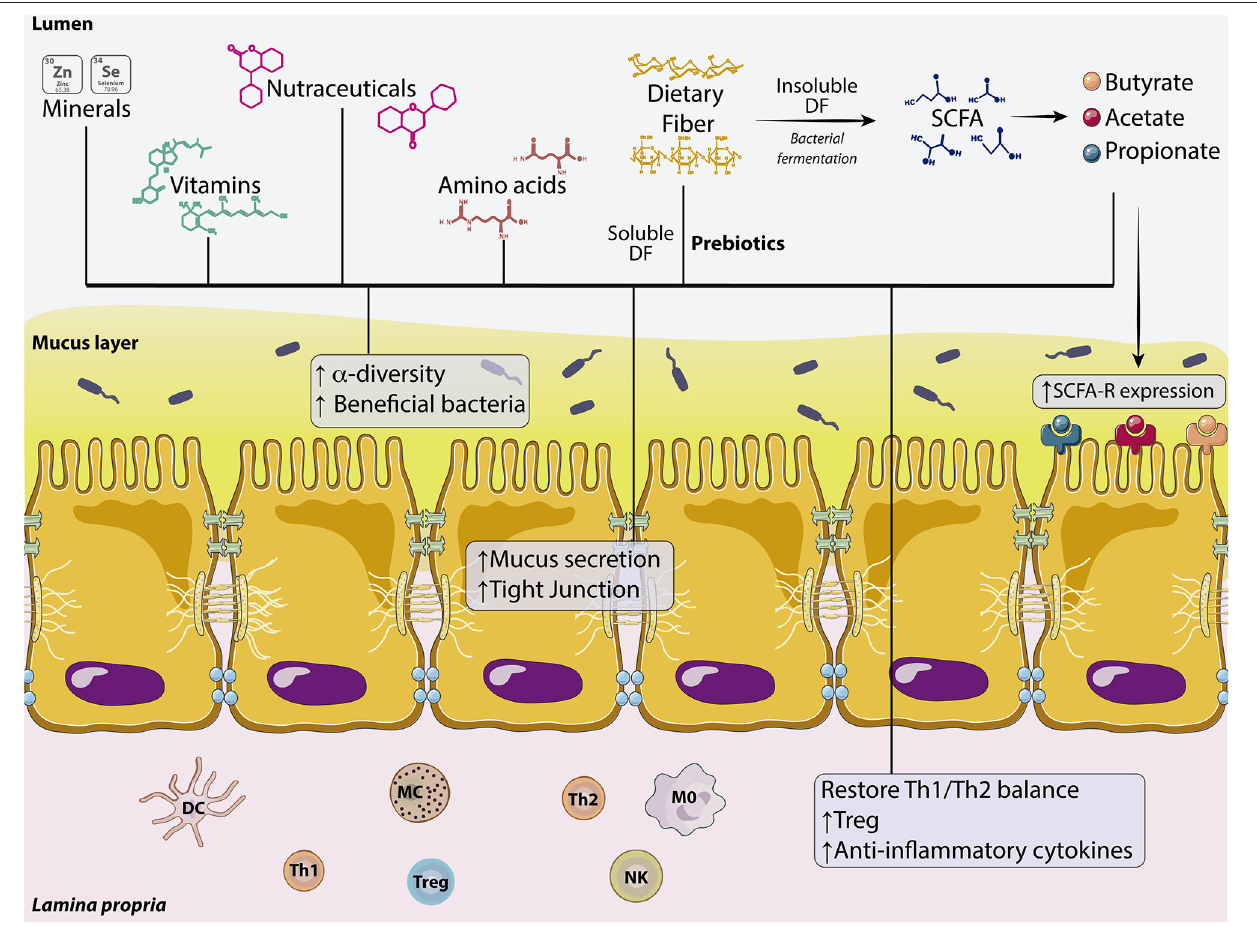
FIGURE 2 | Dietary components involved in the regulation of intestinal permeability. Effects of minerals, vit, nutraceuticals, amino acids, soluble DFs (prebiotics), and SCFAs on the intestinal barrier. These dietary components are capable of affecting the microbiota by increasing α -diversity and the number of beneficial bacteria. DFs also enhance mucus secretion from the IEB and increase the expression of TJs proteins. In the lamina propria , dietary compounds increase T reg population, but also the production of anti-inflammatory cytokines restoring the Th1/Th2 balance. Fermentation of insoluble DF to SCFA (butyrate, acetate, and propionate) also increases the expression of SCFA receptors. DC, Dendritic cell; DF, Dietary fiber; IEB, Intestinal epithelial barrier; M0, Macrophage type 0; MC, Mast cell; NK, Natural Killer; Th1, T helper lymphocyte type 1; Th2, T helper lymphocyte type 2; Treg, T regulatory lymphocyte; SCFA, Short chain fatty acid; Vit,